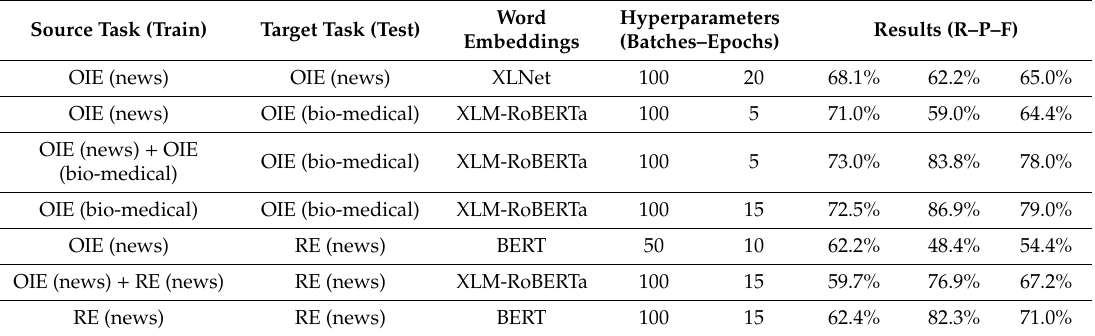
Table 9. Summary of the best result obtained in each experiment by di ff erent systems described in the paper: original ROIE model, transferring from OIE to bio-medical OIE (transductive transfer learning, inductive transfer learning, traditional learning), and transferring from OIE to (transductive transfer learning, inductive transfer learning, traditional